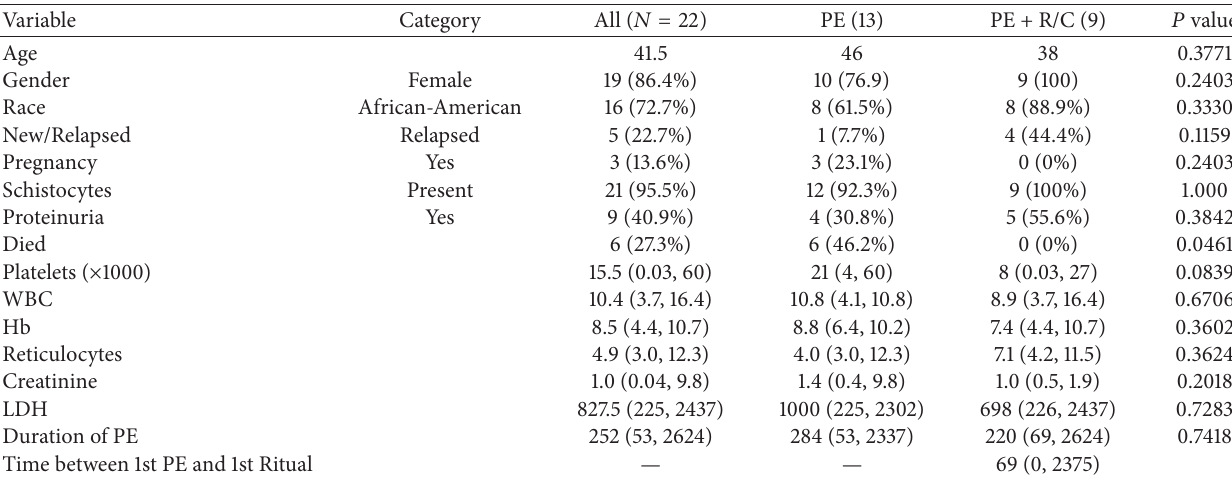
Table 1: Characteristics of patients in PE and PE + R/C